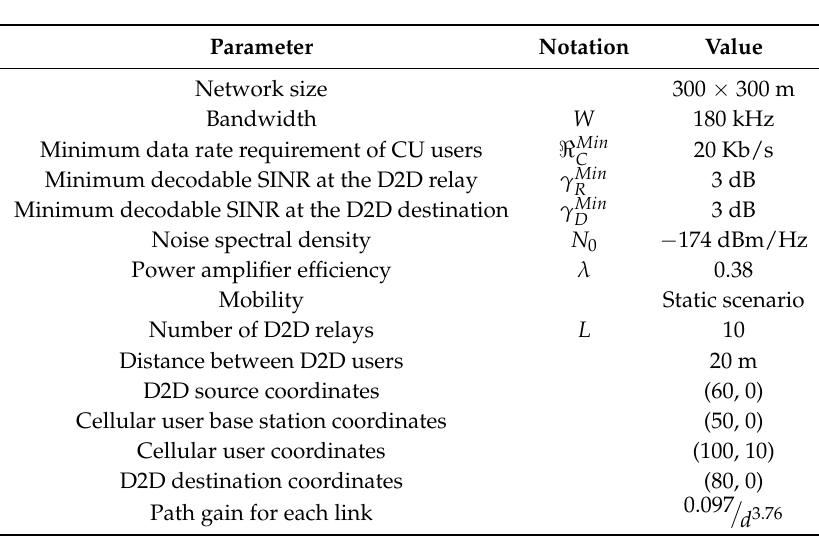
Table 4. Simulation